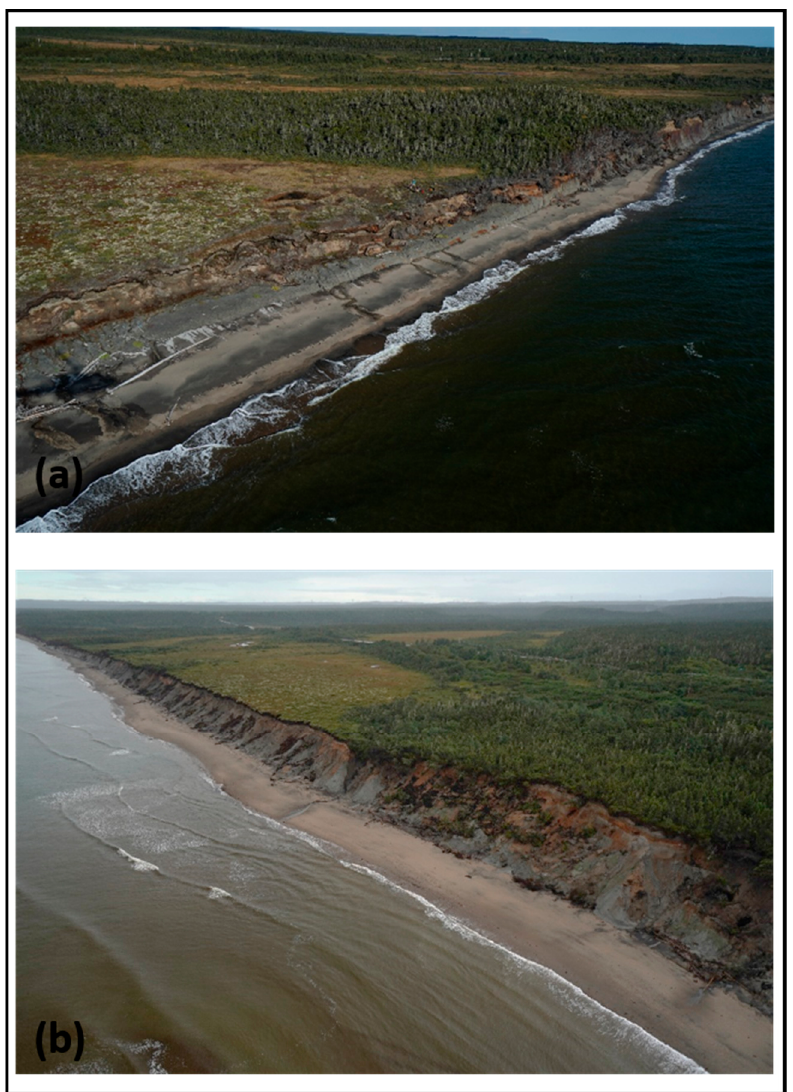
Figure 2. Overview of the study area. ( a ) Western part, view of zone A and B; ( b ) eastern part, view of zone D.